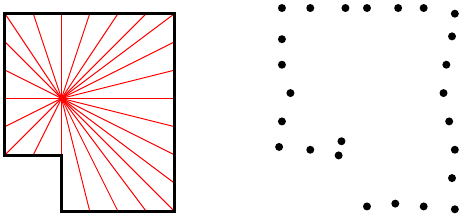
Figure 5. Example of a bird’s eye view of a room outline (left) with 2-dimensional laser ranging device. The noisy LiDAR ’returns’ are shown on the